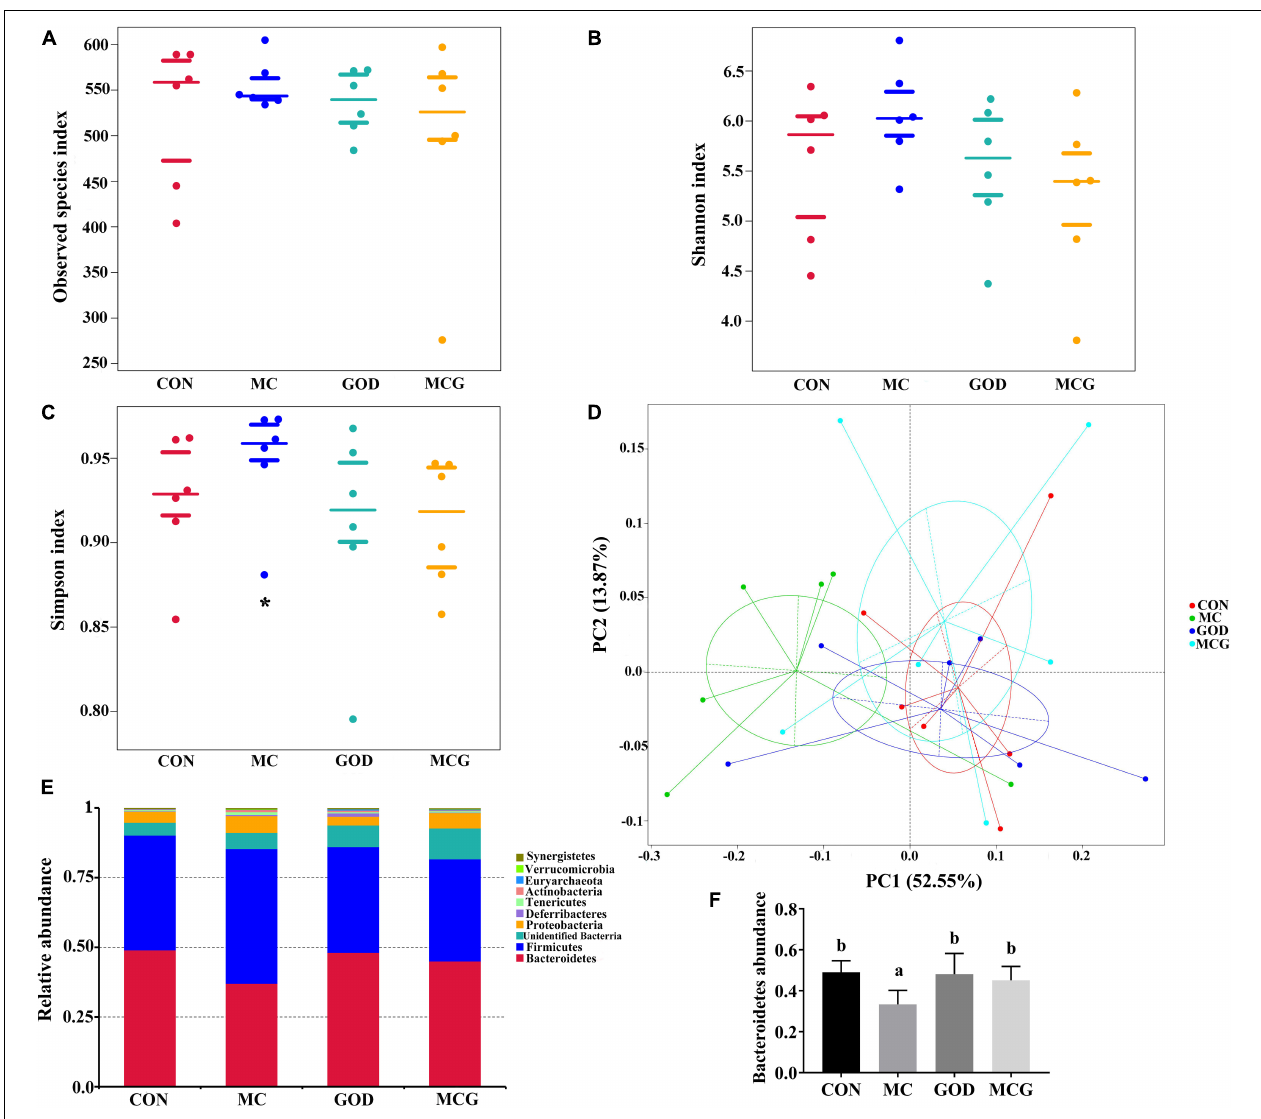
FIGURE 5 | Effects of glucose oxidase on cecal microbiota composition in broiler chickens fed mold contaminated corn. (A) Observed species index; (B) Shannon index; (C) Simpson index; (D) PCoA plot of the microbiota based on an unweighted UniFrac metric; (E) relative abundance of predominant bacteria at the phylum level; (F) relative abundance of Bacteroidetes . *Significant differences at P ≤ 0.05. n =